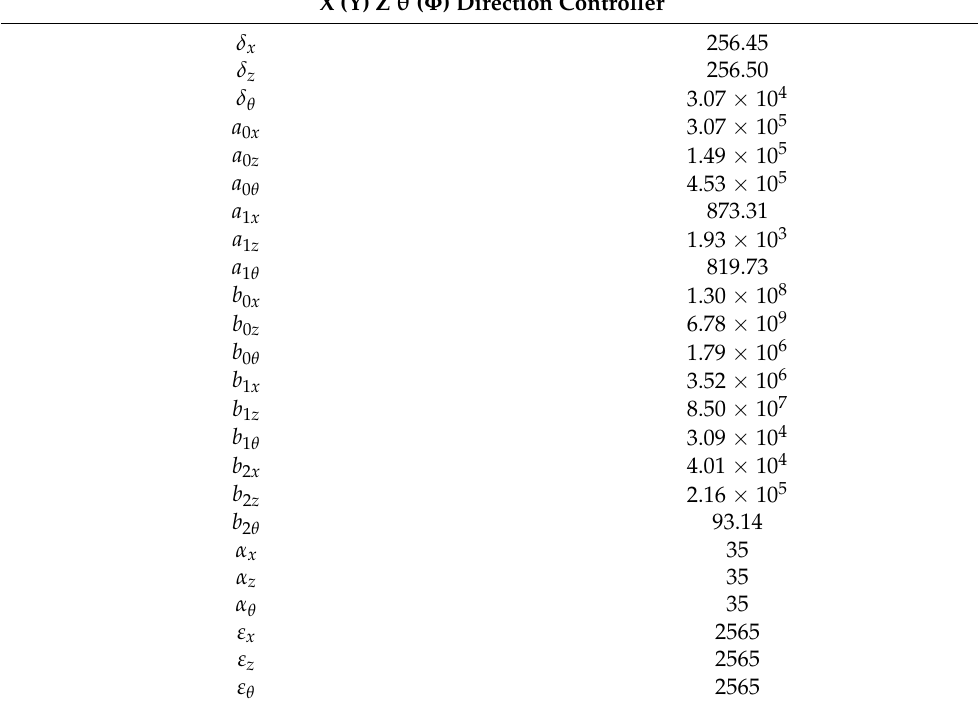
Table 2. Control